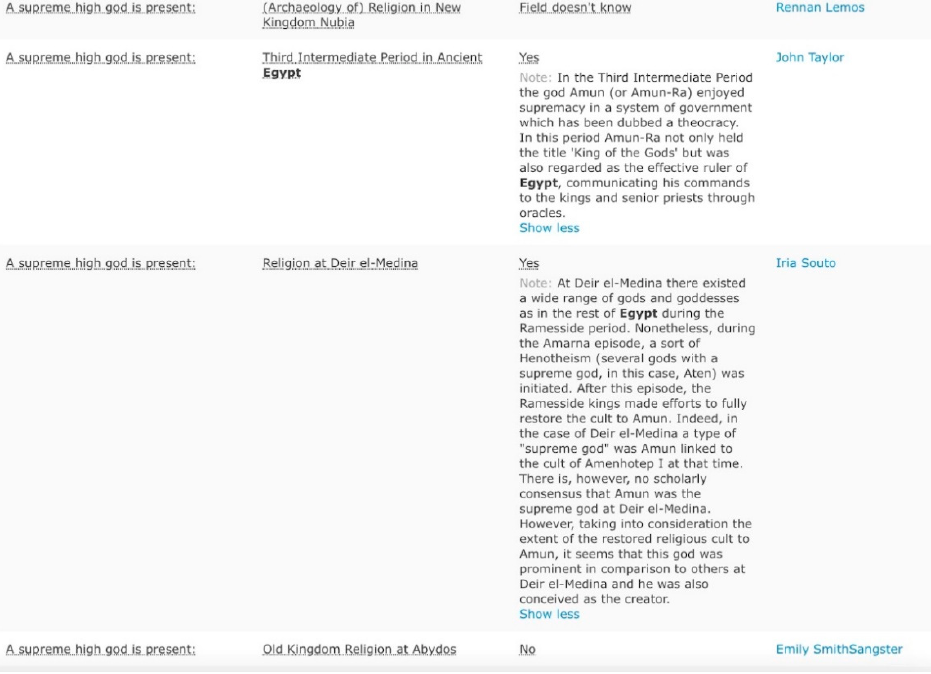
Figure 3. DRH table view of the query “ A supreme high god is present ” based on answers from Pharaonic Egypt.